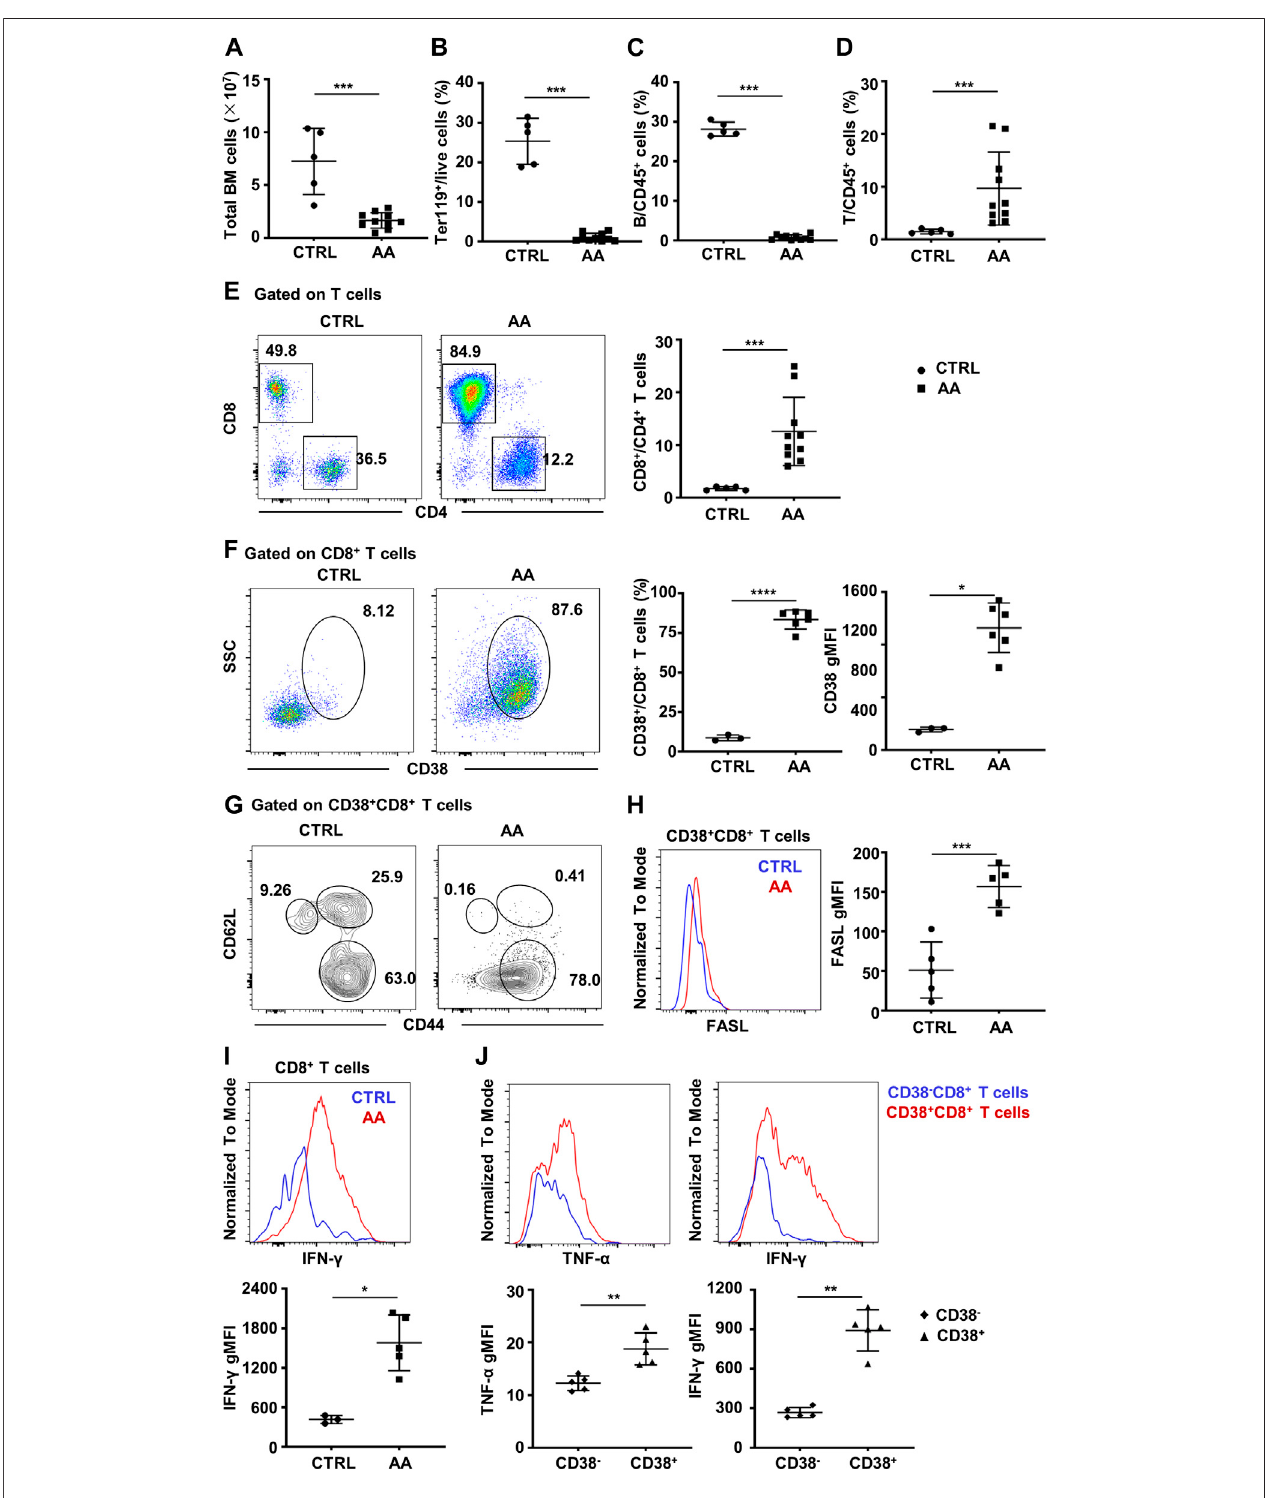
FIGURE5| CD38 + CD8 + Tcellsincreasein BMofmurineAAmodel. (A) BM totalnucleatedcellnumbersofAAmodel ( n (cid:1) 10) and CTRLmice ( n (cid:1) 5). Percentages of Ter119 + cells (B) , B cells (C) , and T cells (D) of AA model ( n (cid:1) 10) and CTRL mice ( n (cid:1) 5); Mann – Whitney test. (E) Representative fl ow cytometry result and of the percentages of CD8 + and CD4 + T cells and statistical analysis of CD8 + /CD4 + T cell ratio between AA model ( n (cid:1) 10) and CTRL mice ( n (cid:1) 5); Mann – Whitney test. (F) Representative fl ow cytometry result of CD38 expression on BM CD8 + T cells and statistical analysis of CD38 + CD8 + T cells (Student ’ s t -test) and geometry MFI